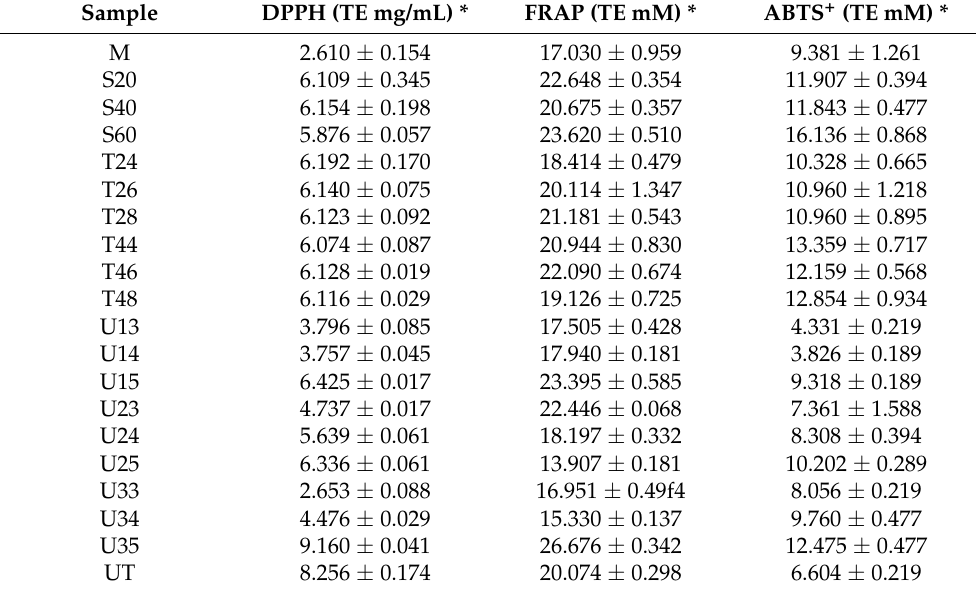
Table 3. In vitro antioxidant capacity of the